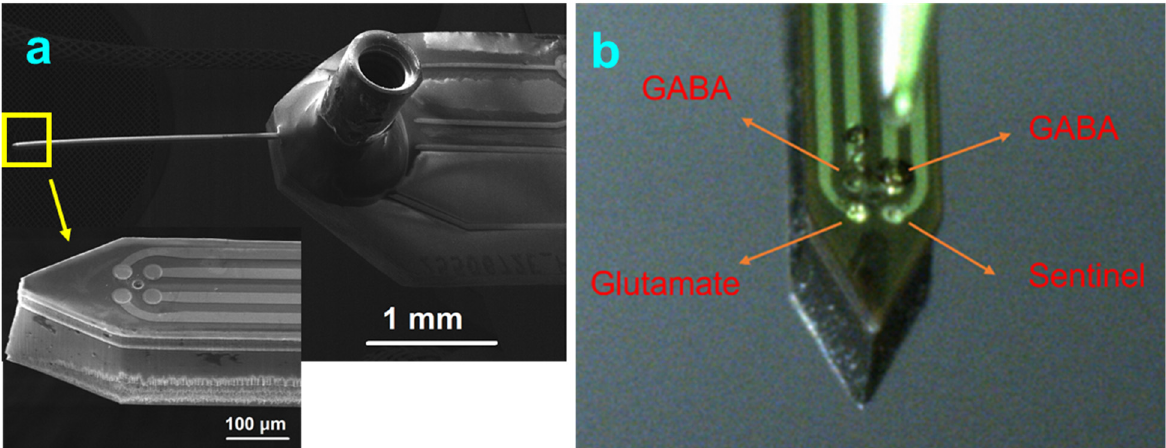
Figure 1. ( a ) SEM images of the Si probe with microfluidic connector. The probe is 200 μ m × 200 μ m × 10 mm. The four Pt UMEs are 25 μ m in diameter. The spacing between the UMEs is 50 μ m. The UMEs surrounds the microfluidic port located at the center. ( b ) Optical image of the probe tip showing the surface modification of UMEs with enzyme and matrix coatings.